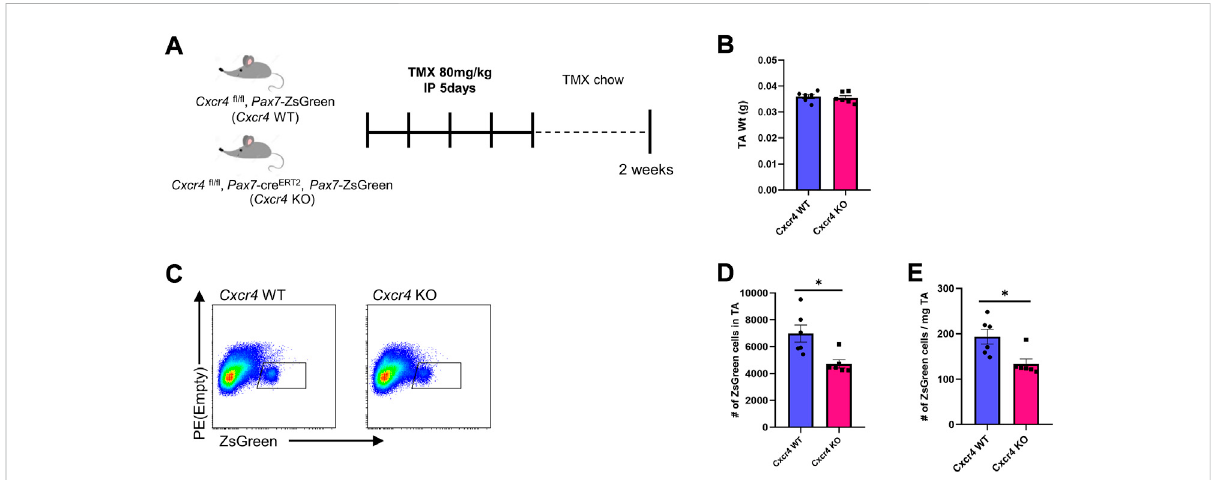
FIGURE 3 CXCR4 is necessary for satellite cell maintenance. (A) Schematic for Tamoxifen treatment and time of analysis. (B) TA mass normalized to body weight in Cxcr4 WT and KO mice. (C) Representative FACS plots from Cxcr4 WT and KO groups showing total number of ZsGreen + cells in the